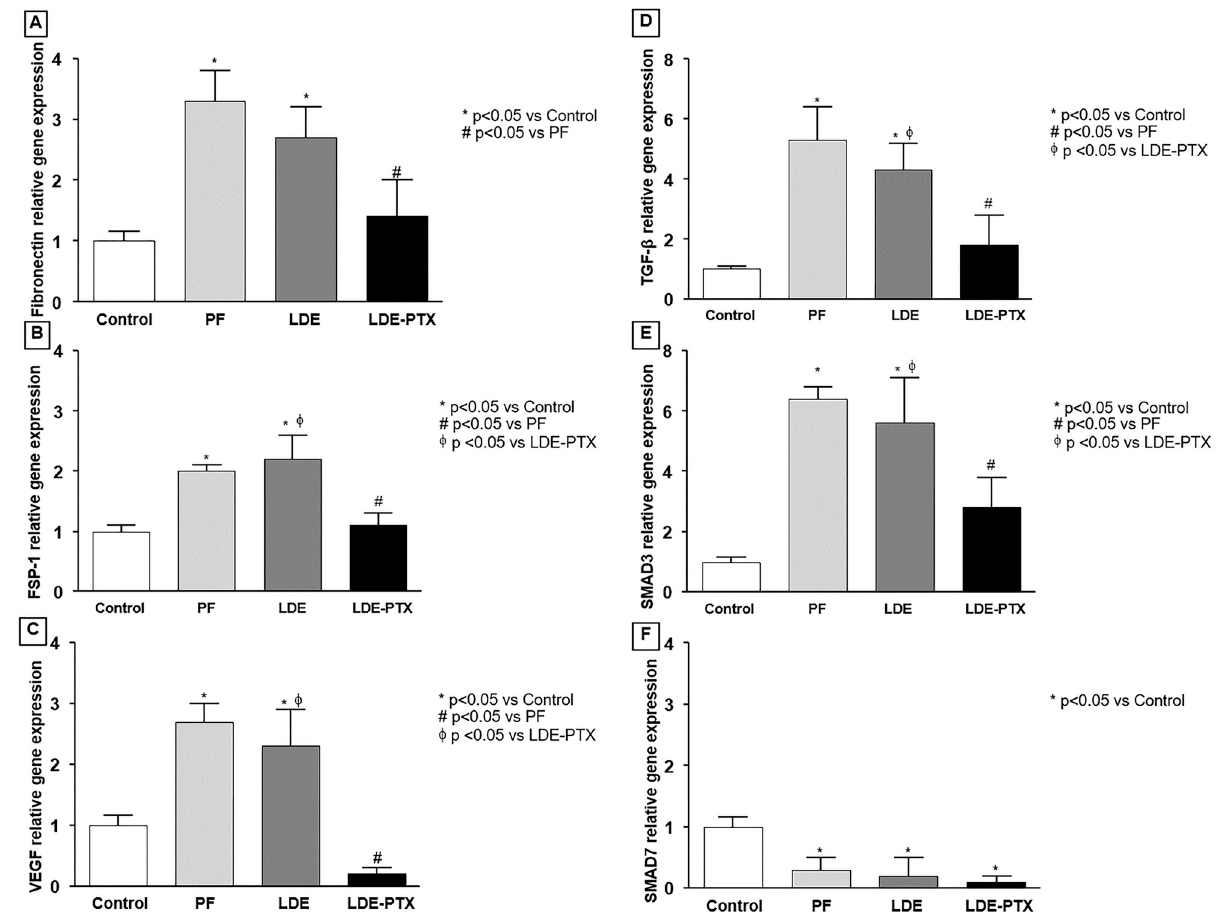
Fig 5. LDE-PXT treatment on gene expression analysis. mRNA levels of peritoneal membrane samples were measured by quantitative real-time PCR of (A) fibronectin; (B) fibroblast-specific protein 1 (FSP-1); (C) vascular endothelial growth factor (VEGF); (D) transforming growth factor-beta (TGF- β ); (E) SMAD3; and (F) SMAD7. Relative gene expression (2 - ΔΔ Ct ) of fibronectin (A) , FSP-1 (B) , VEGF (C) , TGF- β (D) and SMAD3 (E) were significantly higher in the PF and LDE groups compared to the Control group ( � p < 0.05). LDE-PXT treatment exhibited an important reduction of mRNA levels of those genes compared to the PF ( # p < 0.05) and the LDE groups ( F p < 0.05). Relative gene expression of SMAD7 (F) was down-regulated in the PF, LDE, and LDE-PTX groups compared to the Controls (p < 0.05).